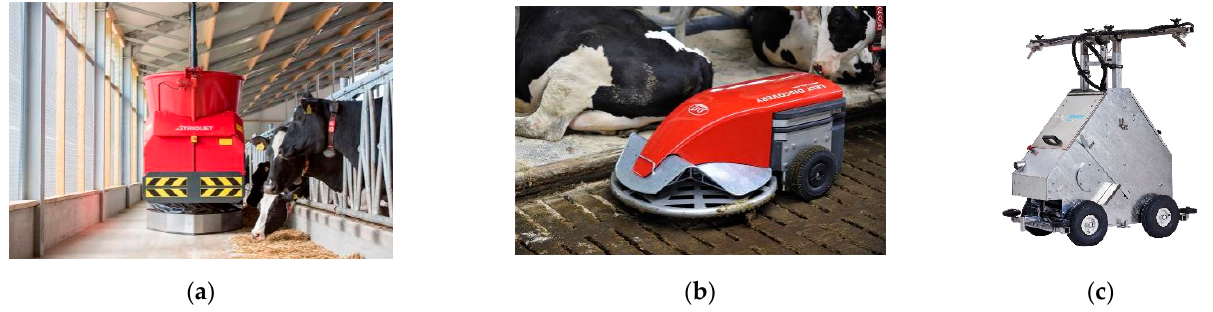
Figure 10. Different types of robot. ( a ) is feeding robot (Source: TRIOLIET Feeding Technology). ( b ) is floor cleaning robot (Source: LELY Industries N.V.). ( c ) is procleaner robot (Source: WASHPOWER).